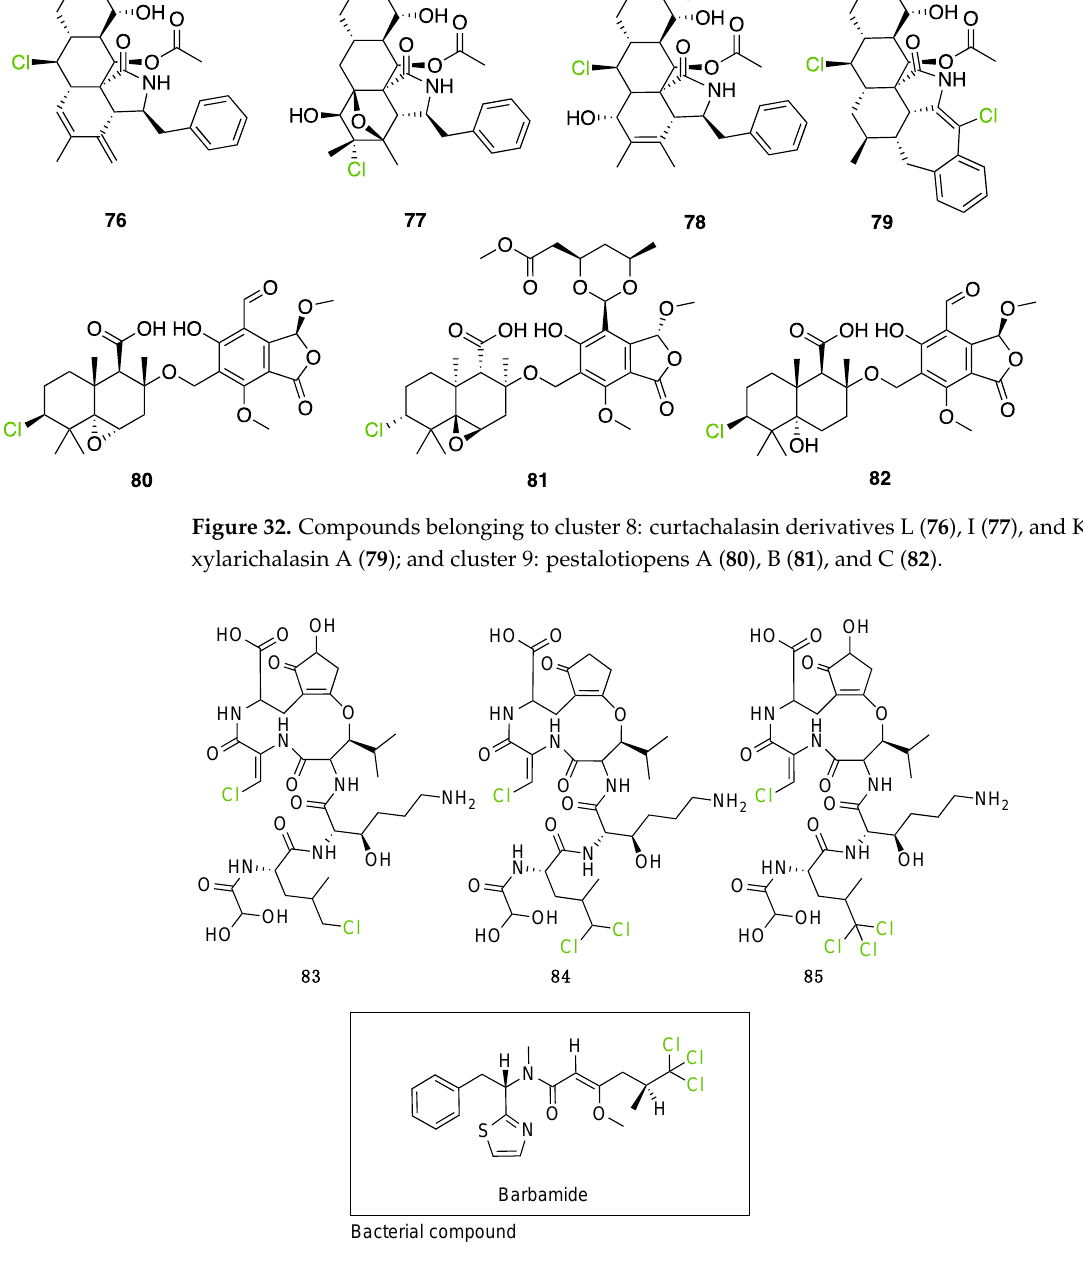
Figure 33. Cluster 10: victorins B ( 83 ), D ( 84 ), and E ( 85 ) from Cochliobolus victoriae and bacterial compound barbamide.